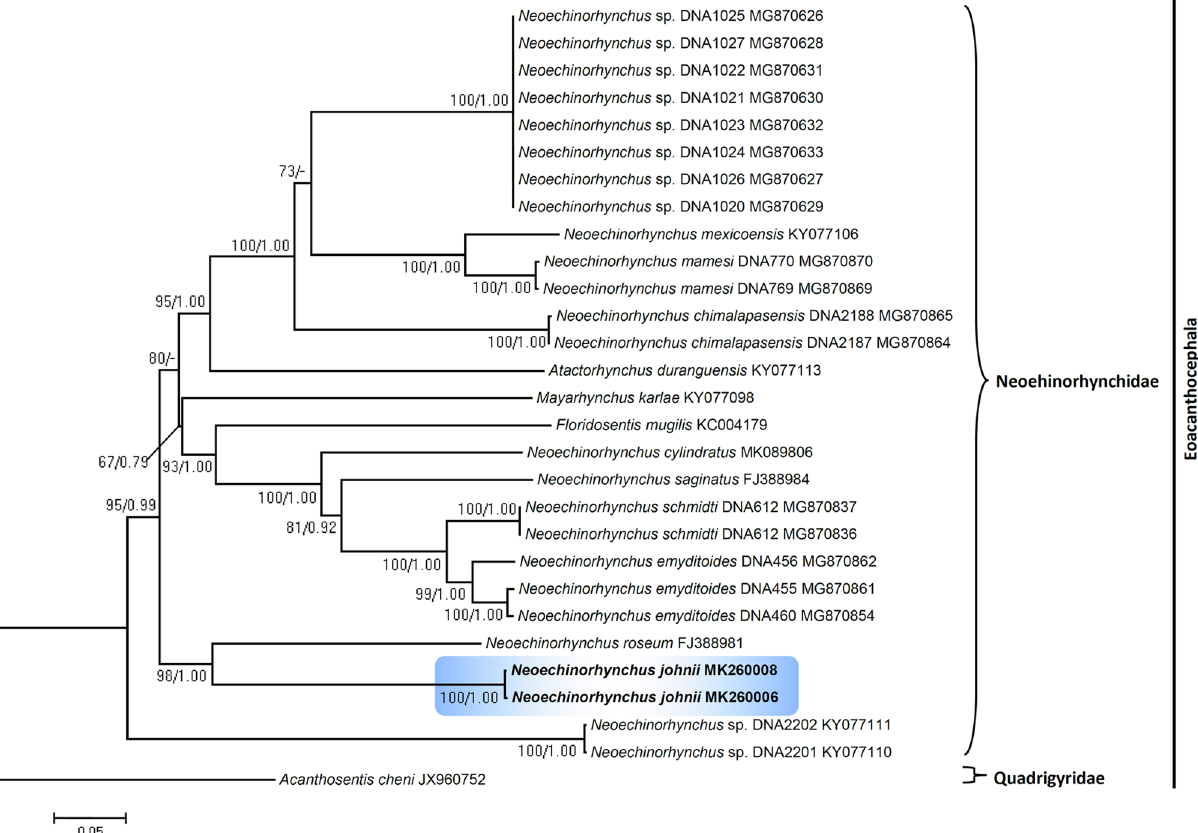
Figure 23. Phylogenetic analysis of the ribosomal ITS1-5.8S-ITS2 region using the maximum likelihood method. Numbers at nodes indicate ML bootstrap values (1000 replications) and posterior probabilities (BI), respectively with GenBank accession numbers listed alongside the species names. Hyphen indicates a node unsupported by BI. Acanthosentis cheni (JX960752) was selected as the out-group species for the ITS1+5.8S+ITS2